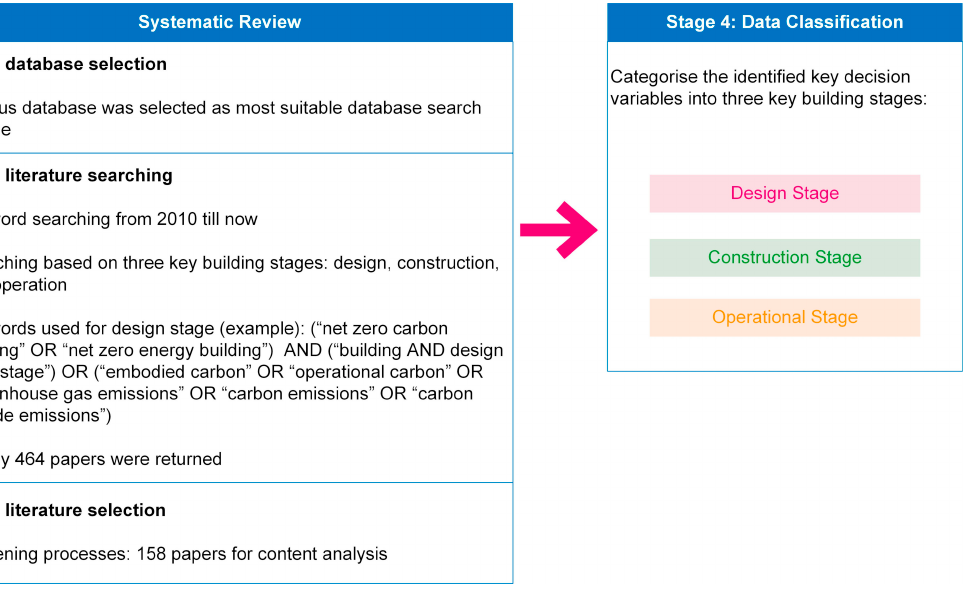
Figure 2. Systematic literature review process for the identification of key decision variables.